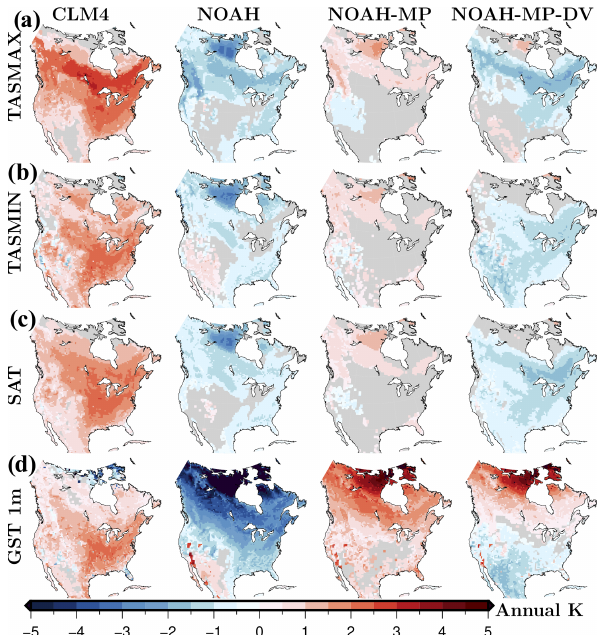
Figure 4. Anomalies of near-surface temperature conditions: (a) daily maximum temperature (TASMAX), (b) daily minimum tem- perature (TASMIN), (c) surface air temperature (SAT) and (d) soil temperature at 1m depth (GST 1m) for each LSM simulation rel- ative to the LSM ensemble mean. Mean values are estimated as the temporal average for the period 1980–2013 using simulations performed with 50km resolution. Grid cells with a non-significant change at the 5% significance level are masked in